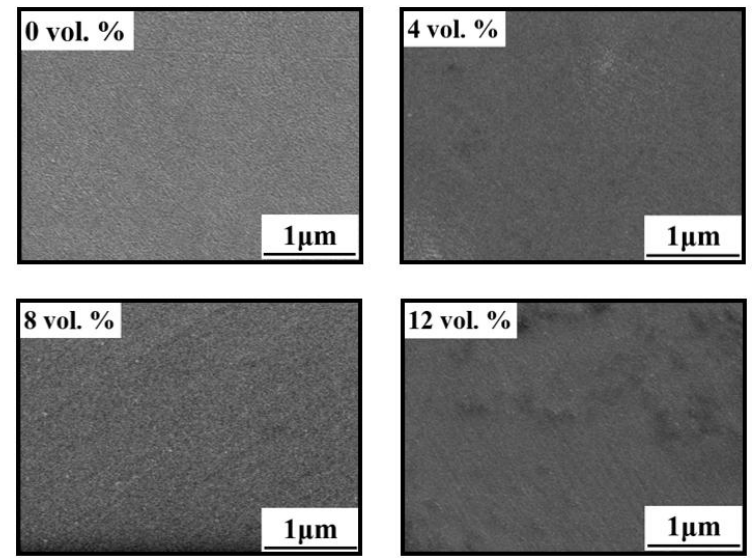
Figure 5. Cross-sectional scanning electron microscope (SEM) image of the Ti 50 Cu 28 Ni 15 Sn 7 bulk metallic glasses (BMG) and composite samples after vacuum hot pressing at 723 K under a pressure of 1.2 GPa.